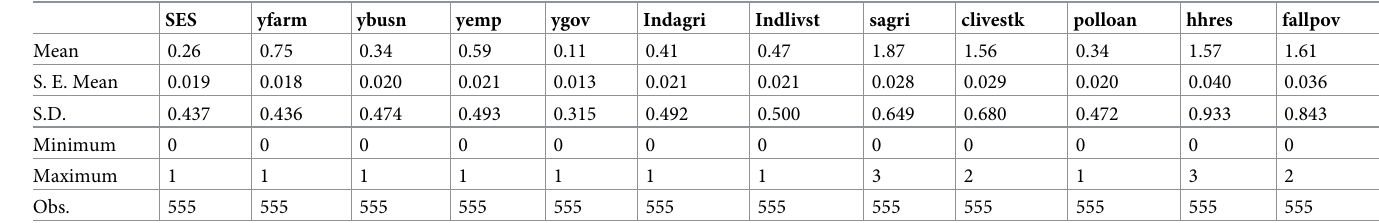
Table 2. Descriptive